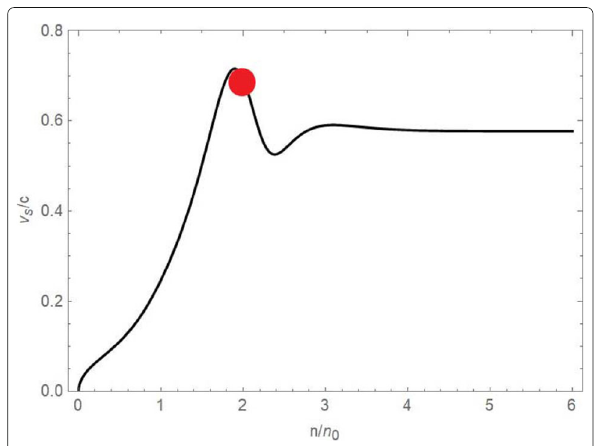
Fig. 4 Sound velocity calculated using V lowk RG with n 1 / 2 = 2 n 0 . The solid circle indicates where the topology change takes place